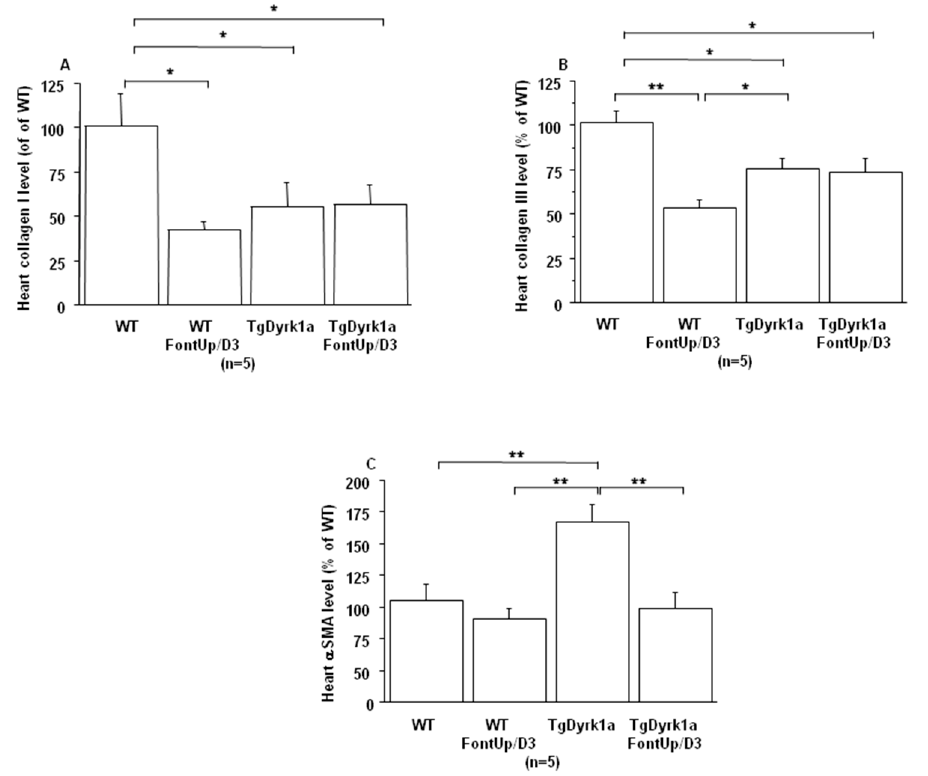
Figure 5. Comparison of relative heart collagen I ( A ), collagen III ( B ) and α SMA ( C ) protein levels based on slot blot analysis obtained from WT and mice overexpressing Dyrk1A (TgDyrk1A) after oral gavage of D3 FontUp ® during eight days (FontUp / D3). Values were obtained by normalization of images from collagen I, collagen III or α SMA to total proteins marked with Ponceau-S. The values are mean ± SEM of n (number of mice) mice normalized to the mean of WT mice without FontUp ® . Statistical analysis was done as mentioned in data analysis. * p < 0.05; ** p < 0.005.